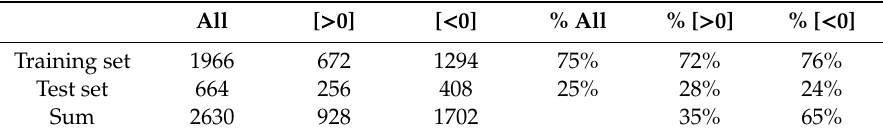
Table 1. Quantitative characteristics of training set and the test